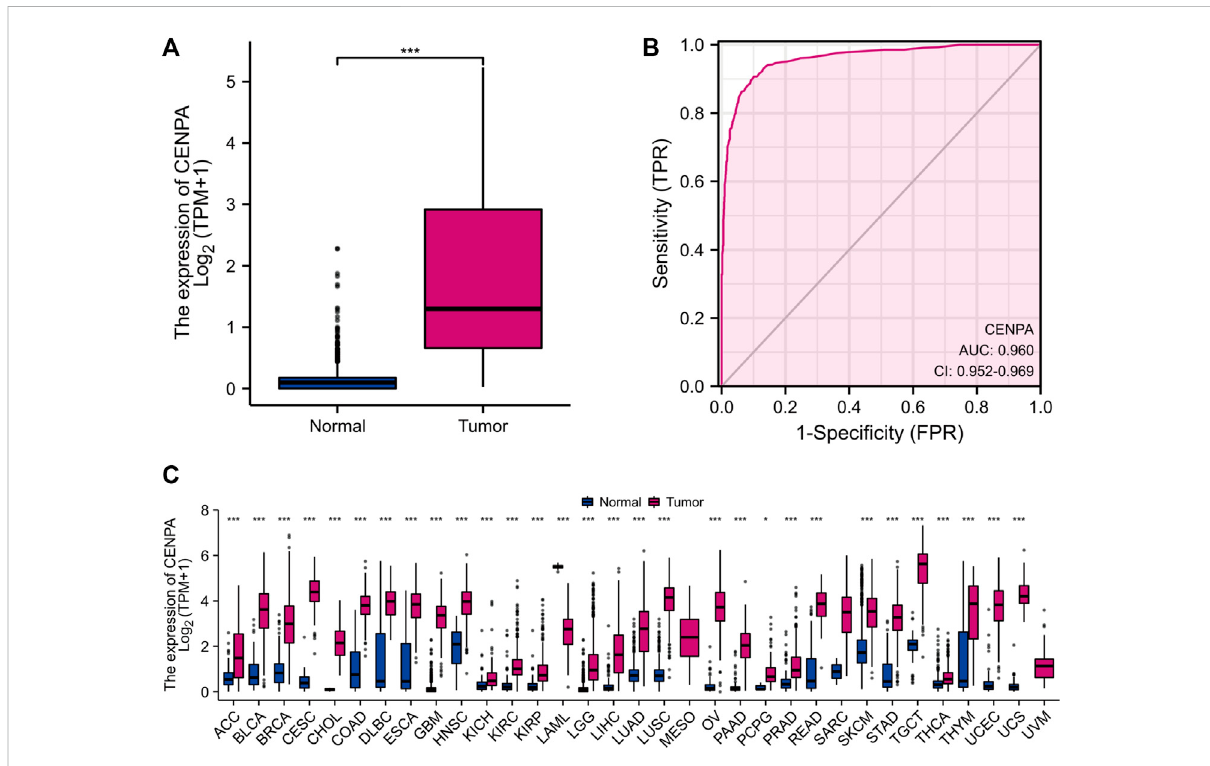
FIGURE 1 High CENP-A expression in tumor tissues. (A) CENP-A expression levels in glioma tissues compared with normal tissues (control). (B) ROC analysis of CENP-A expression showing its excellent ability in distinguishing tumors from normal tissues. (C) Pan-cancer analysis of CENP-A expression across different cancers based on TCGA data. ns, no signi fi cance, p > 0.05; * p < 0.05; ** p < 0.01; *** p <